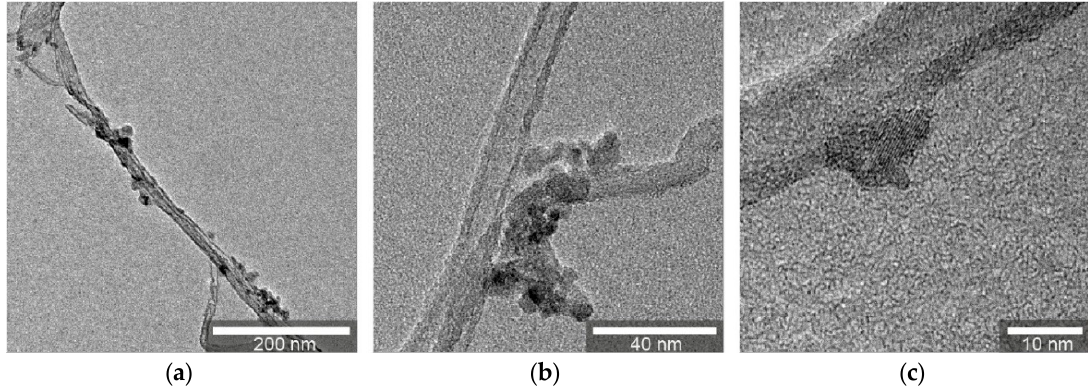
Figure 2. TEM images of TiO 2 –fCNT at different magnifications showing the distribution and attachment of TiO 2 nanoparticles on the pCNT walls: scale bar ( a ) 200 nm, ( b ) 40 nm, and ( c ) 10 nm.